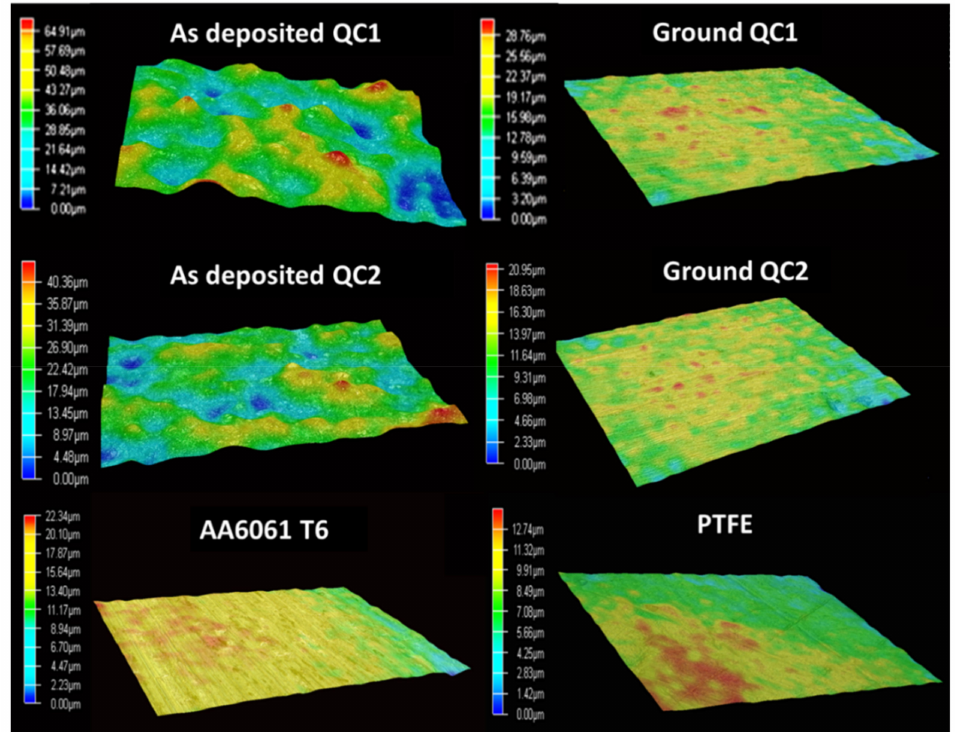
Figure 11. 3D topographical images of the QC coatings as well as the reference materials AA6061 T6 and polytetrafluoroethylene (PTFE).